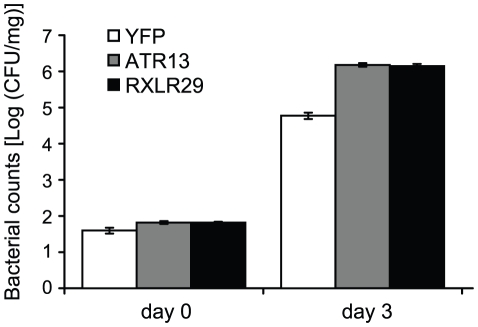
RXLR29 enhances bacterial growth in Arabidopsis leaves.Five-week-old Col-0 leaves were hand-infiltrated with 5×105 cfu/ml Pst DC3000-LUX delivering YFP, ATR13 or RXLR29, as indicated. Bacterial growth in leaves at 0 and 3 dpi was measured by number of colony forming units (cfu) per mg of leaf tissue. Error bars indicate the standard error of bacterial counts. Enhanced growth was observed at day 3 for Pst delivering ATR13 or RXLR29 compared to YFP (T-test p value <0.0005).